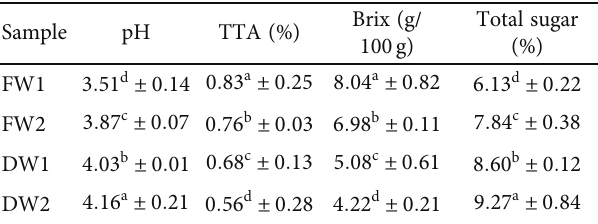
Table 1: Variations in pH, total titratable acidity, brix, reducing sugar, and total sugar of wine